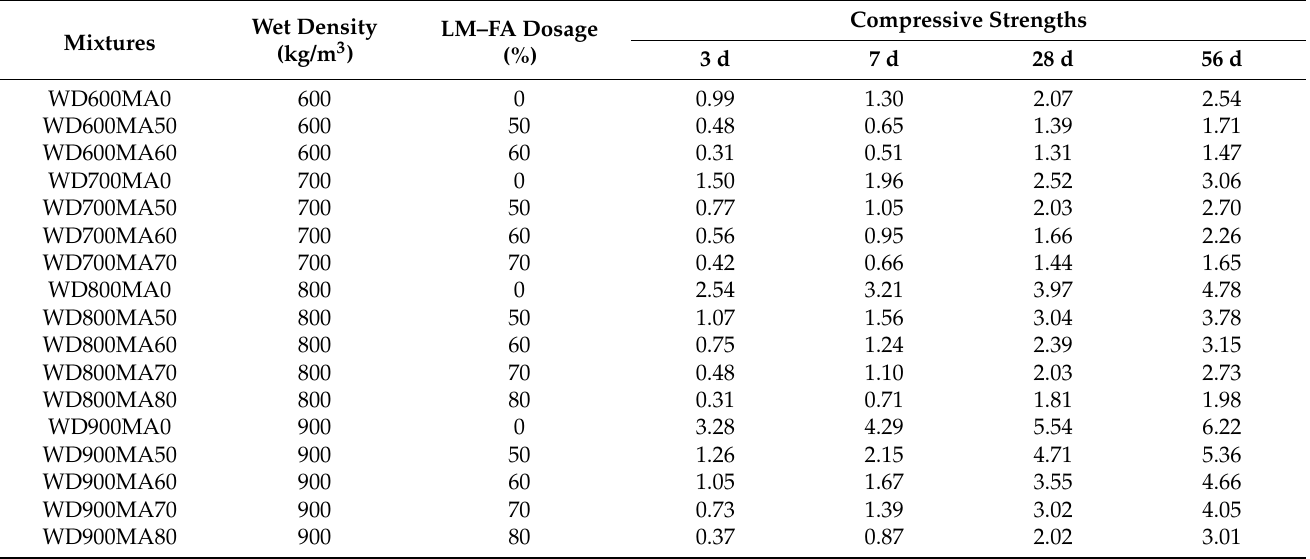
Table 5. Compressive strength of Series II